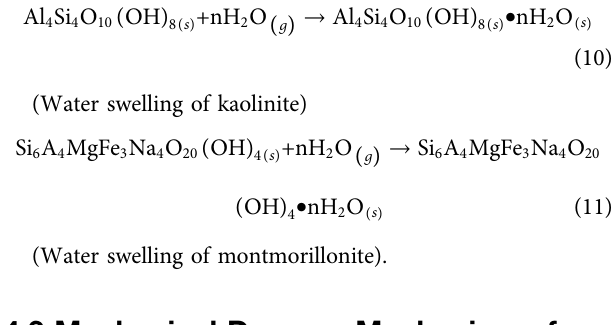
Frontiers in Materials |